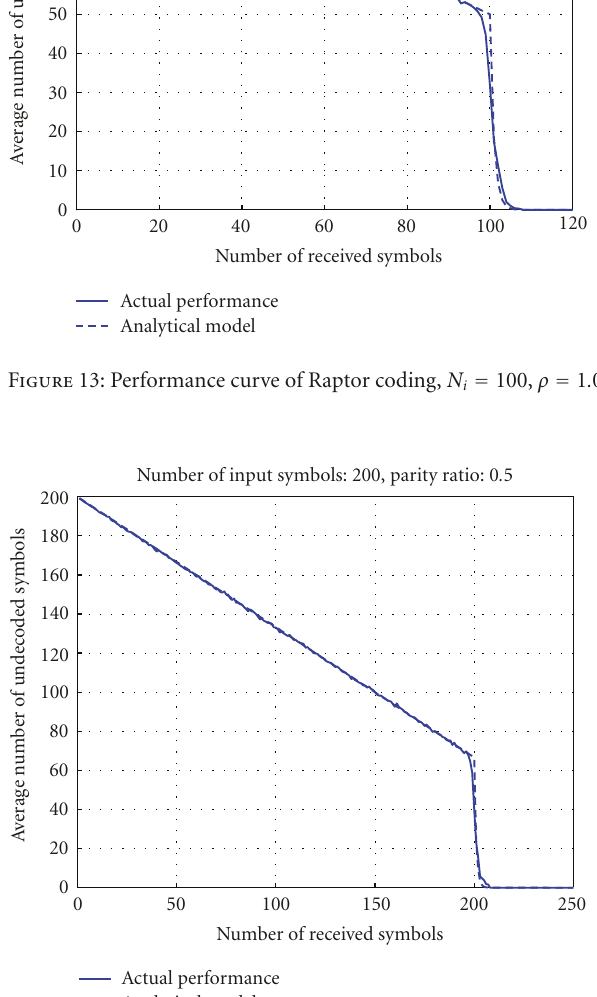
Figure 14: Performance curve of Raptor coding, N i = 200, ρ = 0 . 5